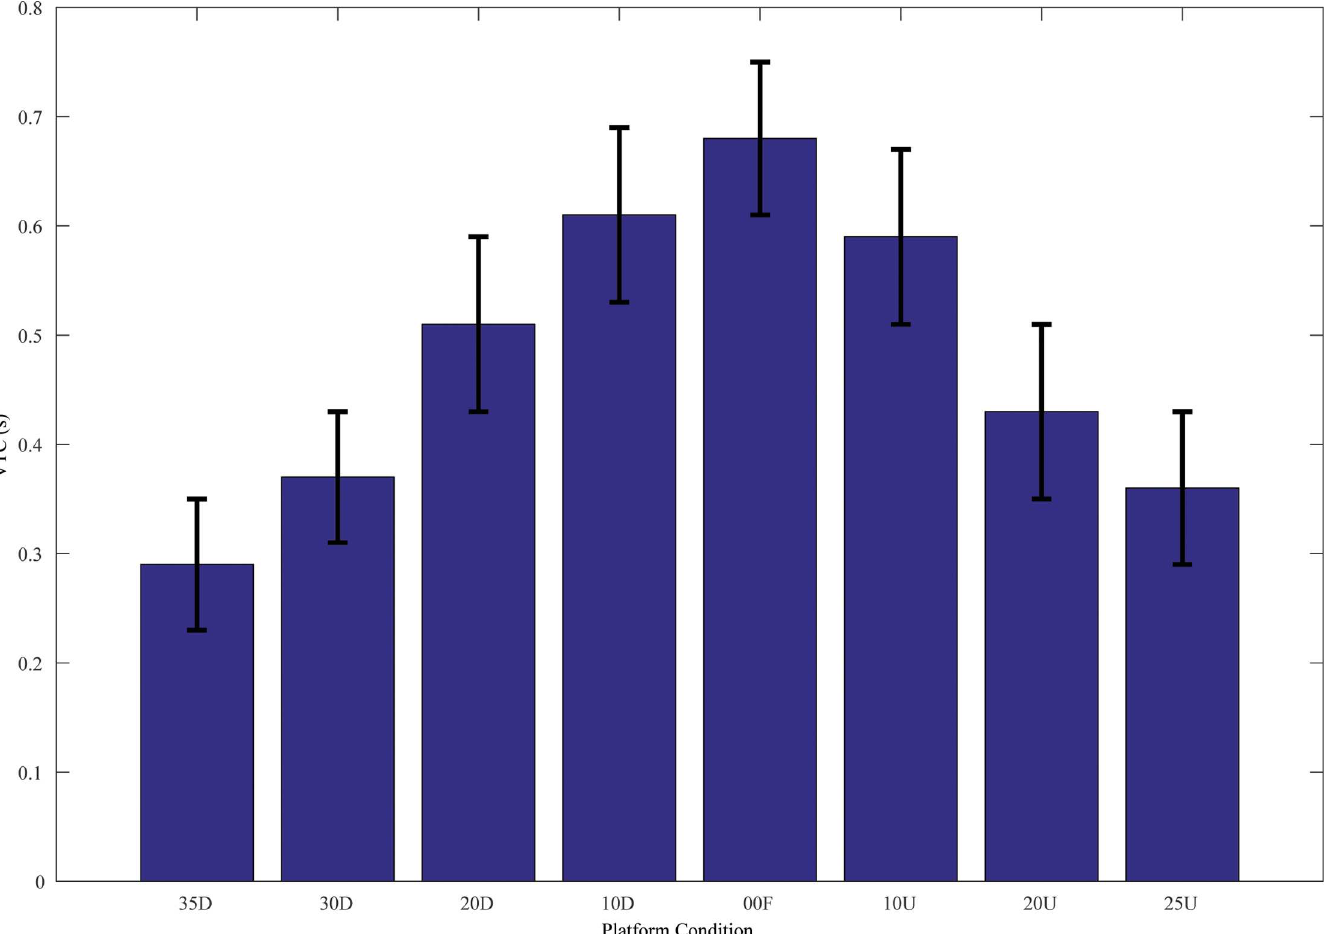
Fig 3. Representative 3D plot of VTC in CoPx and CoPy across all sloped platform conditions. The heel position is towards CoP y and the toes are oriented towards CoP x